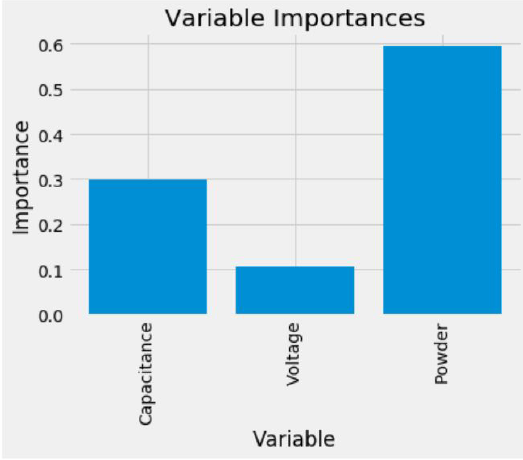
Figure 10. Variable importance matrix from Random Forest